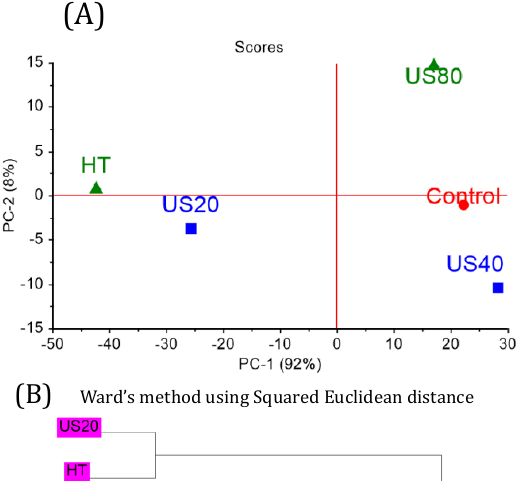
RT = retention time; R 2 = R-squared is a measure for linearity; %RSD = Relative Standard Deviation; <LOQ = below limit of quantification; ND = not determined. Mean values followed by different letter were significantly different at p ≤ 0.05 (Least significant difference test). * Indicates highly significant difference at p- valu e ≤ 0.05. Symbol ↑ indicates higher area.